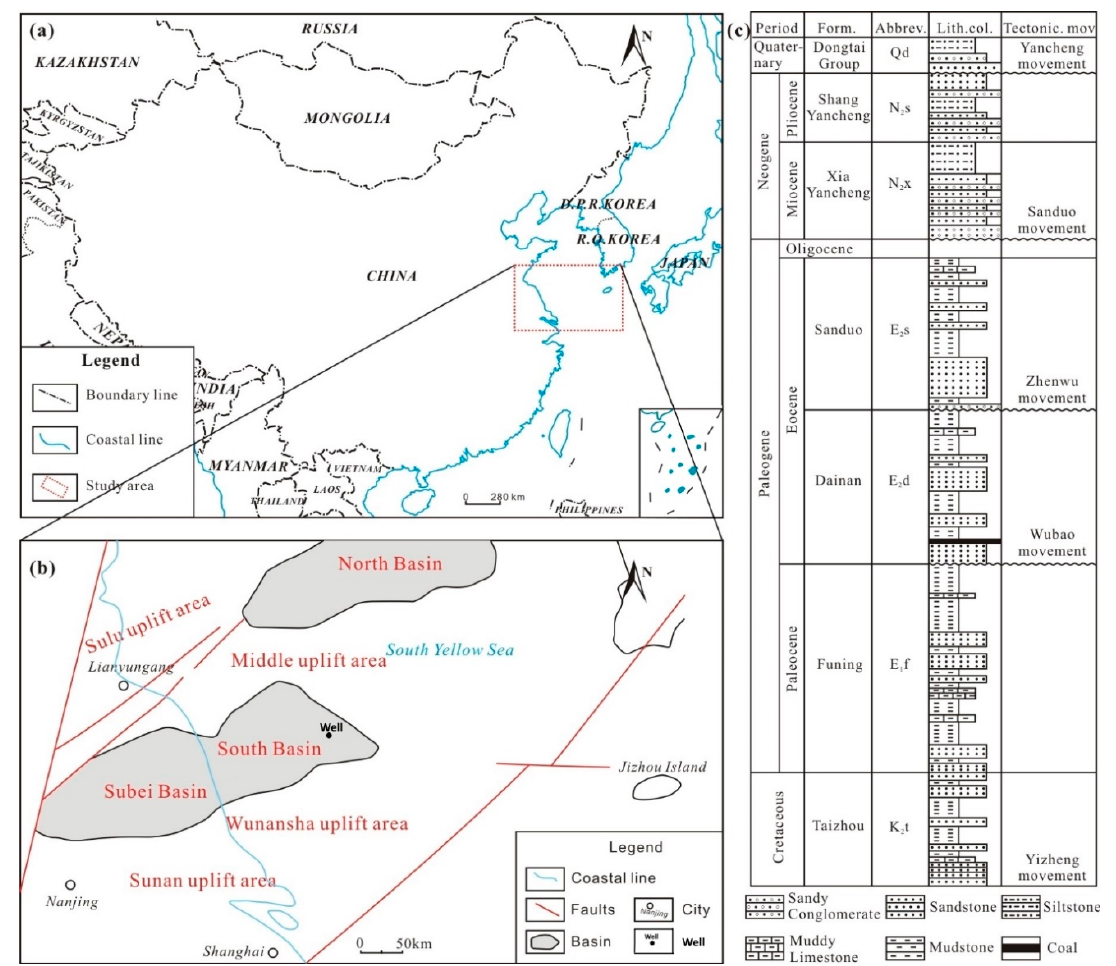
Table 1. Details of the lithology data used in this study.